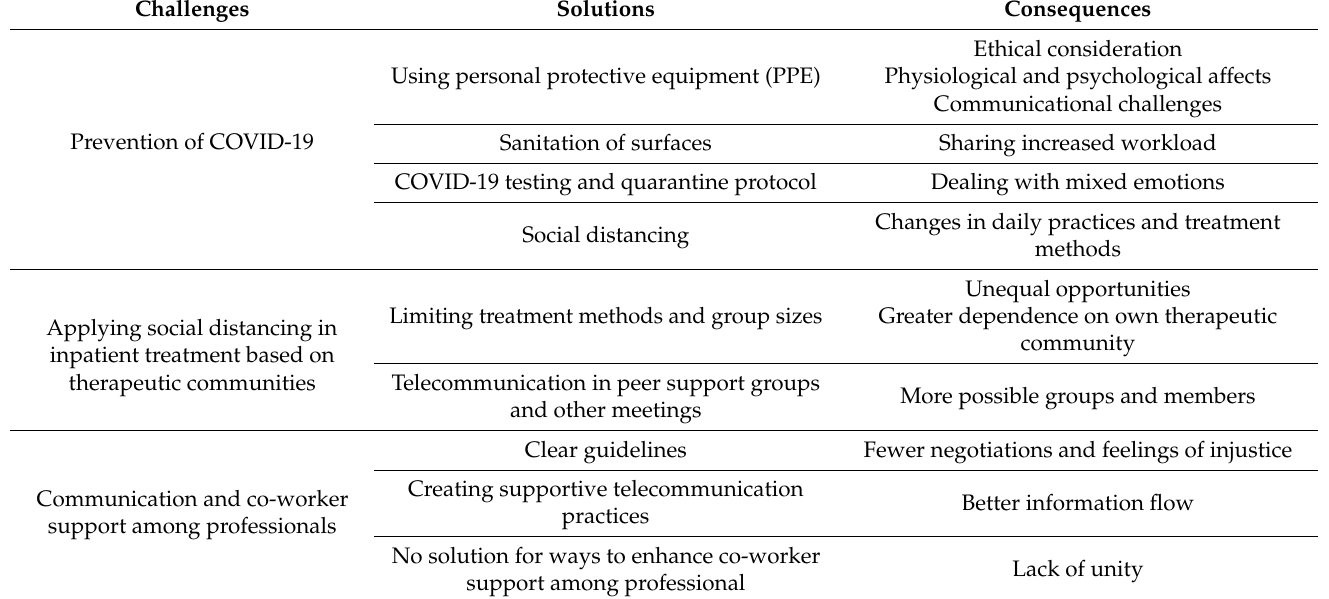
Table 2. Challenges, solutions, and their